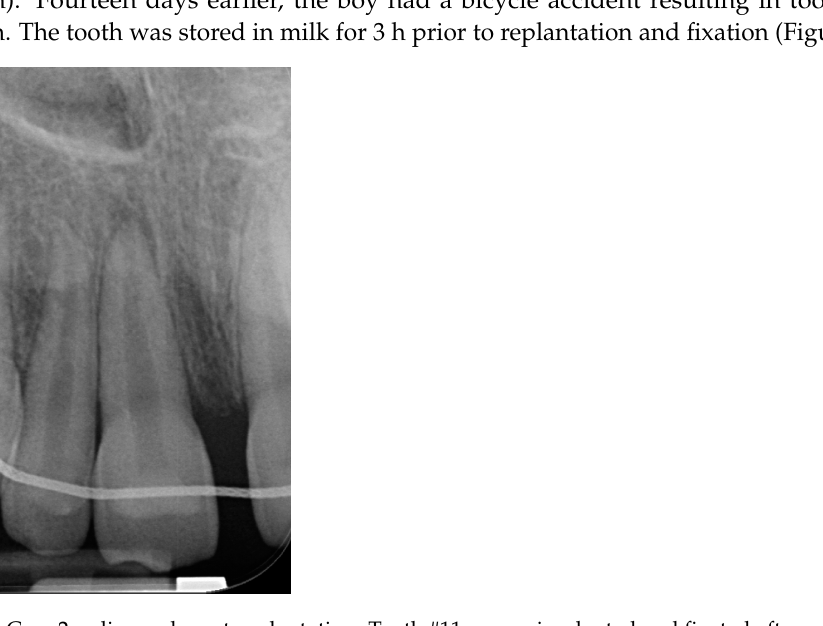
Figure 9. Case 2 radiograph post-replantation. Tooth #11 was re-implanted and fixated after evul- sion.